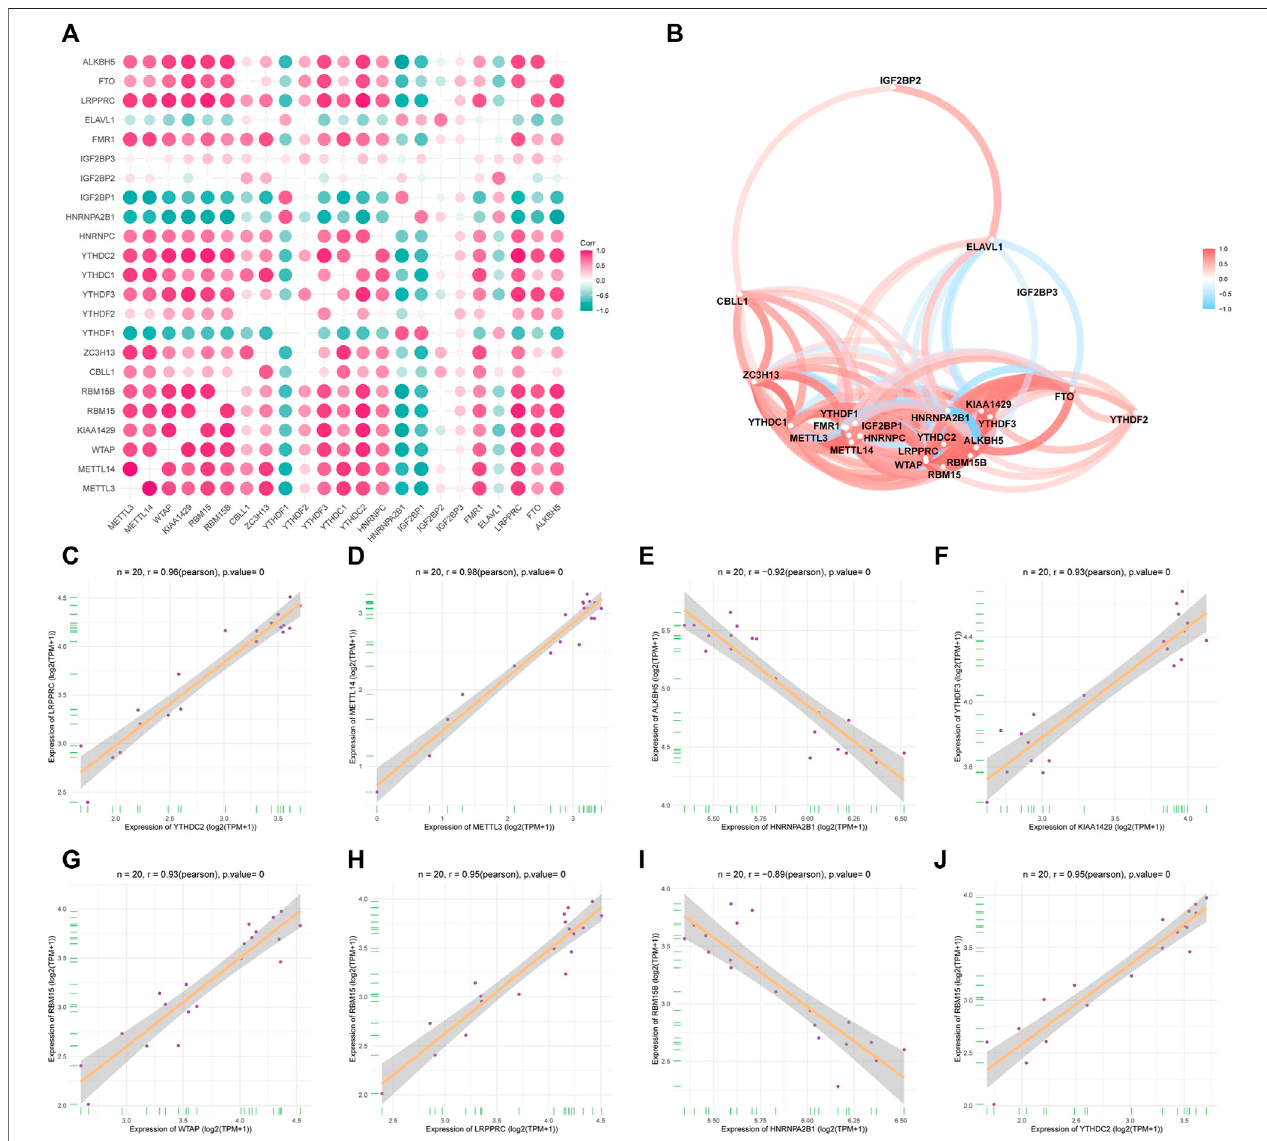
FIGURE 3 | Expression correlation of m6A genes in OA. (A) Heatmap of 23 m6A gene expression correlations. (B) m6A gene expression correlation network diagram. (C – J) Scatter plot of some highly correlated m6A